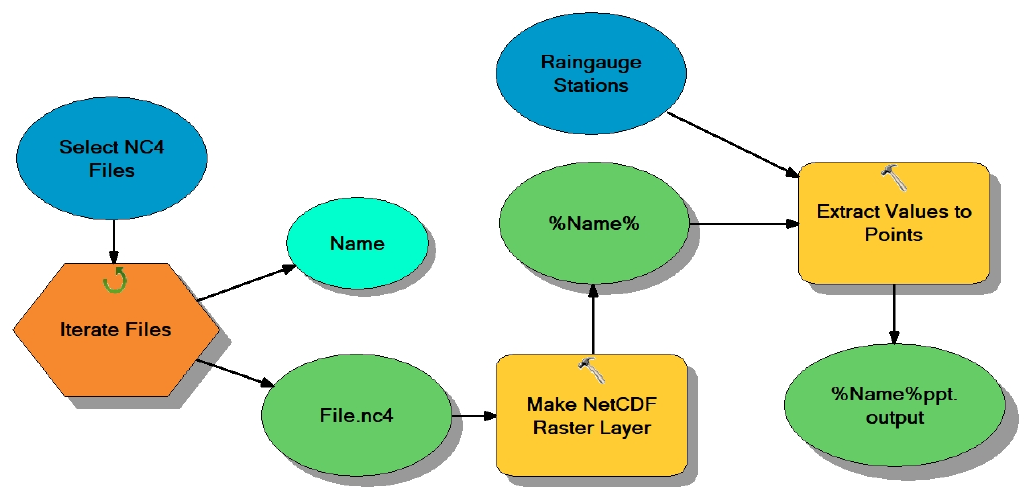
Figure 3. Satellite precipitation (NC4) files processing in ArcMap.